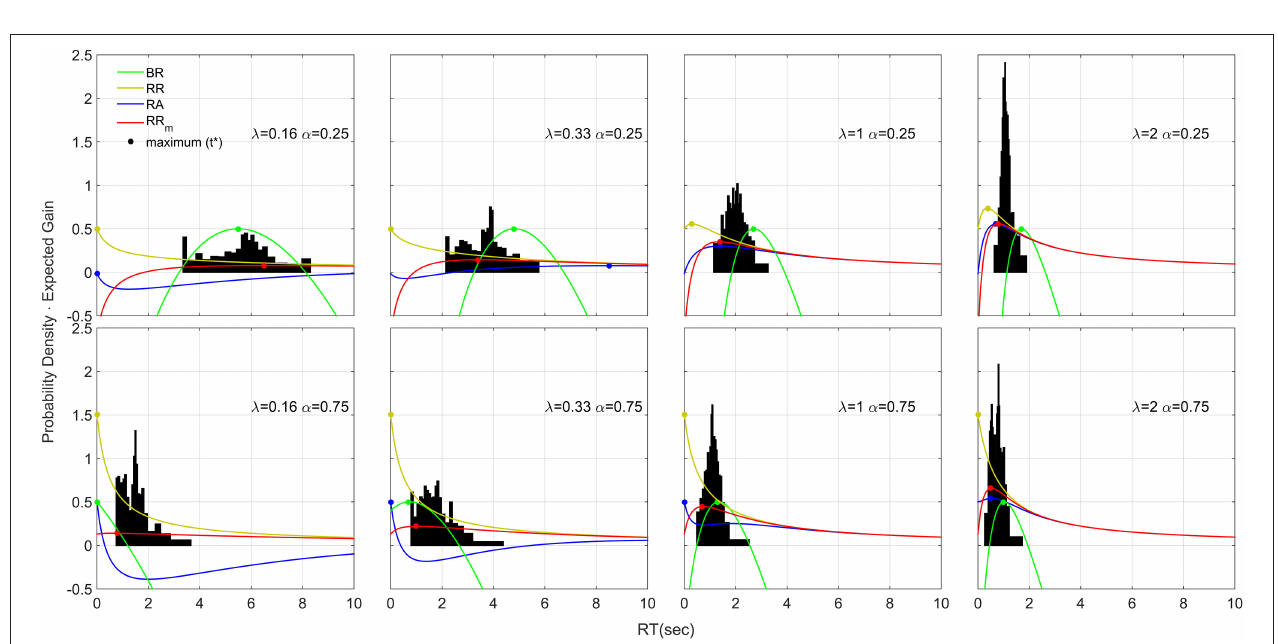
FIGURE 8 | Response Distributions for each condition obtained by averaging the quantiles across each participant and each condition (Vincentizing). The distributions are scaled so that the area of each one is unity. The distributions appear to be skewed on the right side and their shape depends on λ and α . The colored lines refer to four decision rule functions. Note that with respect to the decision rules, the vertical axis corresponds to the expected gain given that particular decision rule. To increase visibility we shift the BR function up by subtracting to the function its maximum value (which was negative) and adding 0.5. In this way the maximum of the BR is always 0.5, but the shape is unchanged. Note that the absolute value of the function is not important for the distribution shape, but the time-depending shape of the decision rule function is. Therefore, shifting the function up or down does not have any theoretical implication for the distribution shape.